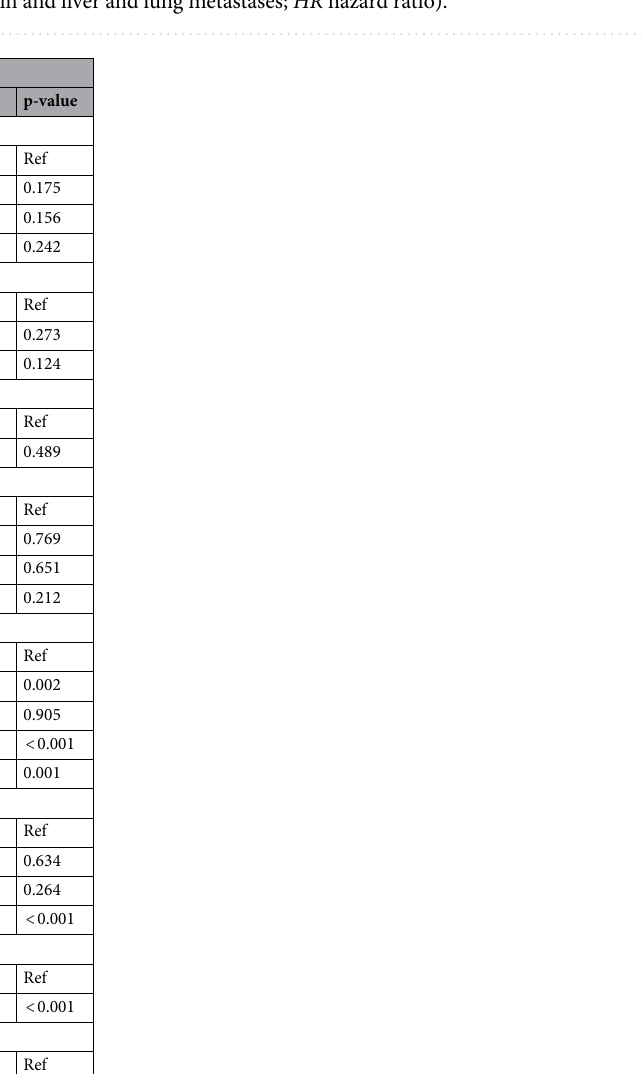
Figure 3. Kaplan–Meier curves and Log-Rank test for OS according to the number of metastasis. ( a ) Only one site metastasis. ( b ) Two sites metastases. 1, Bone and brain metastases; 2, Bone and liver metastases; 3, Bone and lung metastases; 4, Brain and liver metastases; 5, Brain and lung metastases; 6, Liver and lung metastases. ( c ) Three sites metastases. 1, Bone and brain and liver metastases; 2, Bone and brain and lung metastases; 3 Bone and liver and lung metastases; 4, Brain and liver and lung metastases; HR hazard ratio).